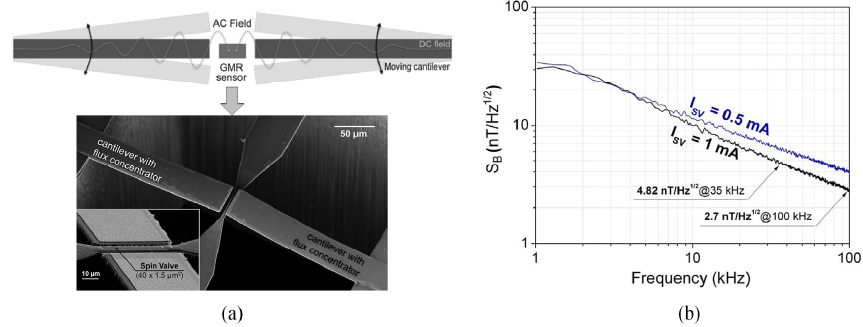
Figure 9. ( a ) The schematic and SEM picture of the integrated device; ( b ) Noise spectrum in magnetic units in the 1–100 kHz range for different biasing currents in the proposed sensor [72].